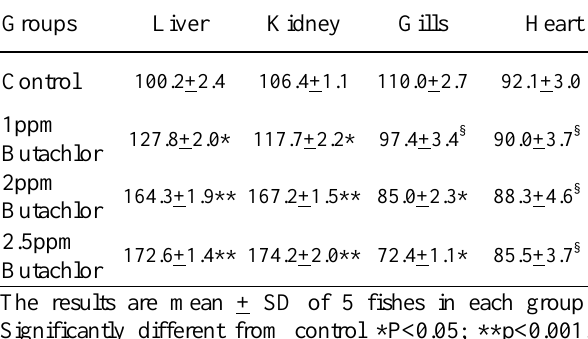
The results are mean + SD of 5 fishes in each group.